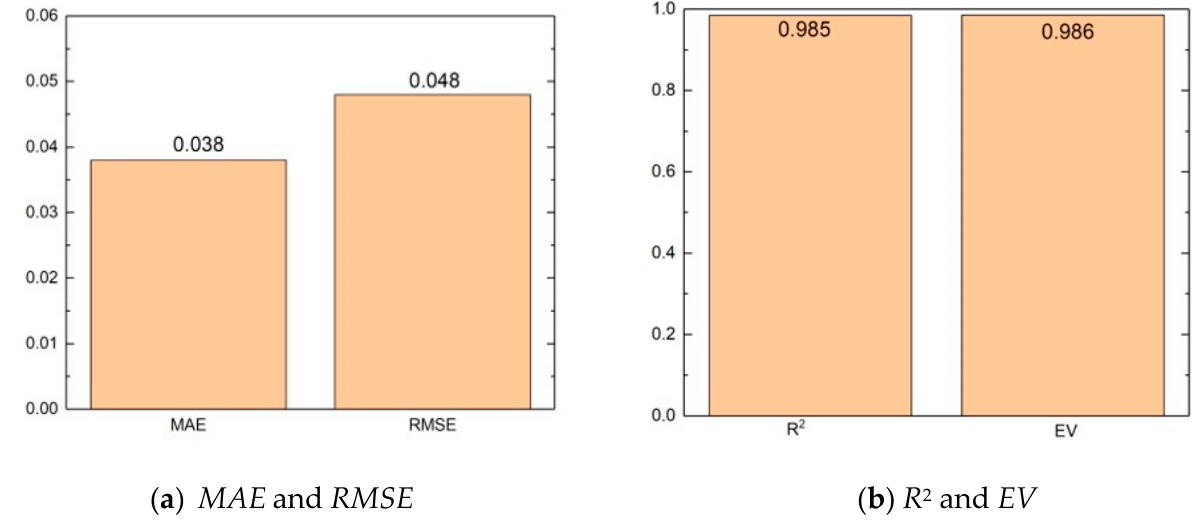
Figure 6. Quality metrics to evaluate the performance of the trained model.